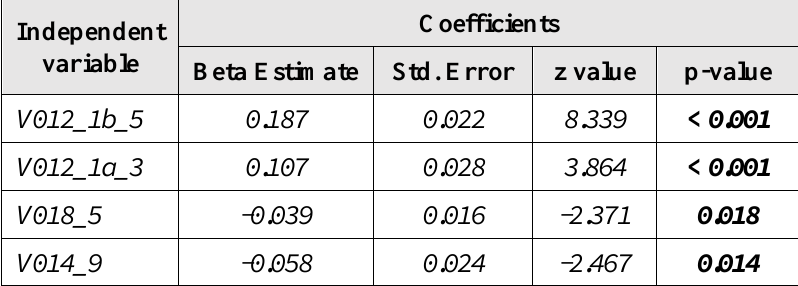
Table 3 ( cont. ) Binary logistic regression model for fatigued driving.